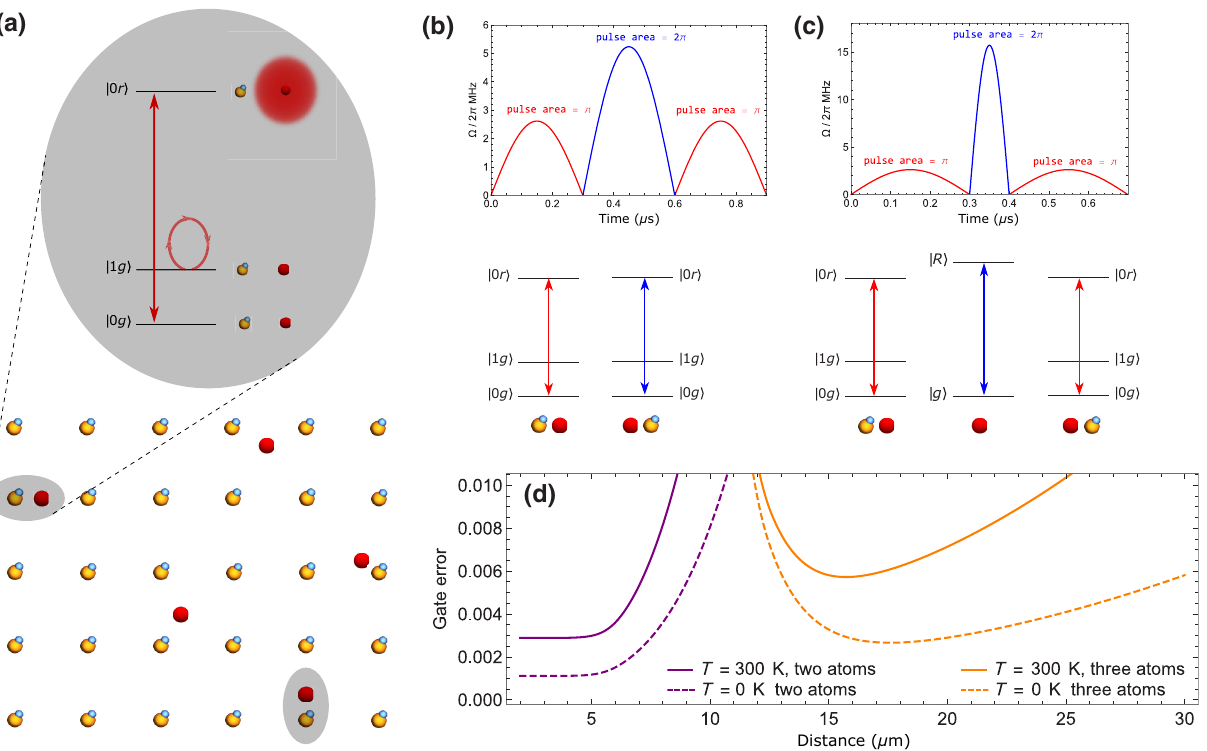
FIG. 4. Long-range entangling gate. (a) In a two-dimensional array of molecular qubits, atoms are moved close to the target pair of molecules (shaded areas). As before, a laser pulse will excite the atom to the Rydberg state when its molecule neighbor is in state | 0 (cid:2) , but not when in state | 1 (cid:2) . (b) Pulse sequence and level scheme for gate operation using two atoms. Red pulses are applied to atom 1, blue pulse to atom 2. (c) Pulse sequence and level scheme for gate operation using three atoms. Red pulses are applied to both outer atoms, blue pulse to central atom. (d) Gate error for the two-atom and three-atom protocols. Here, we use the example of a Rb atom located 0.6 μ m from a CaF molecule, resulting in V DD / 2 = 2 π × 9.5 MHz, as discussed